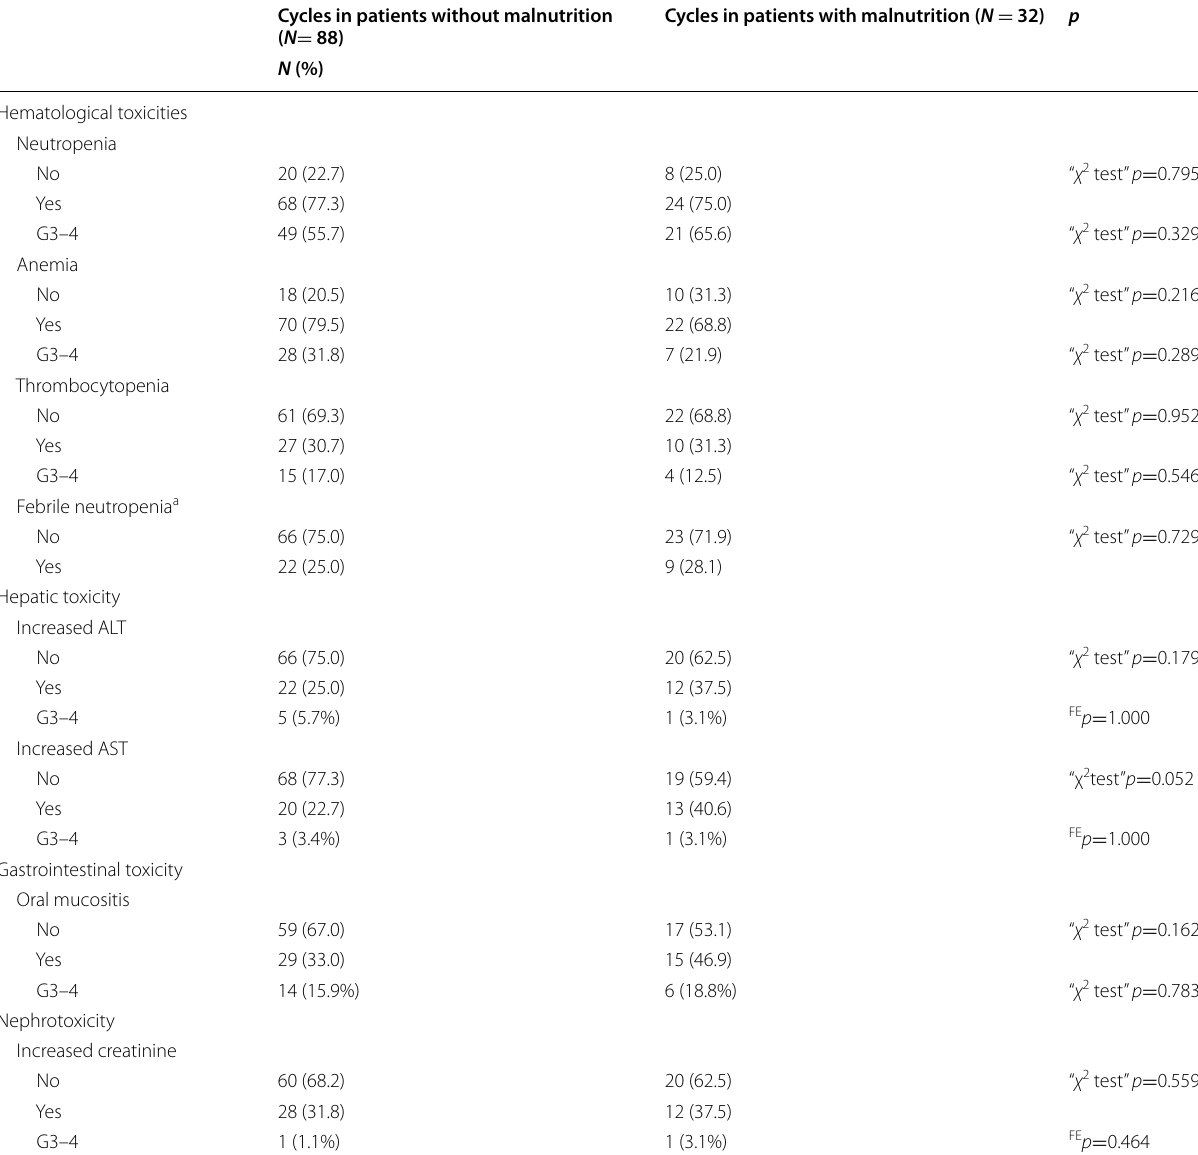
Table 4 Comparison between patients with and without malnutrition according to commonly observed toxicities of the HDMTX cycles ( N =